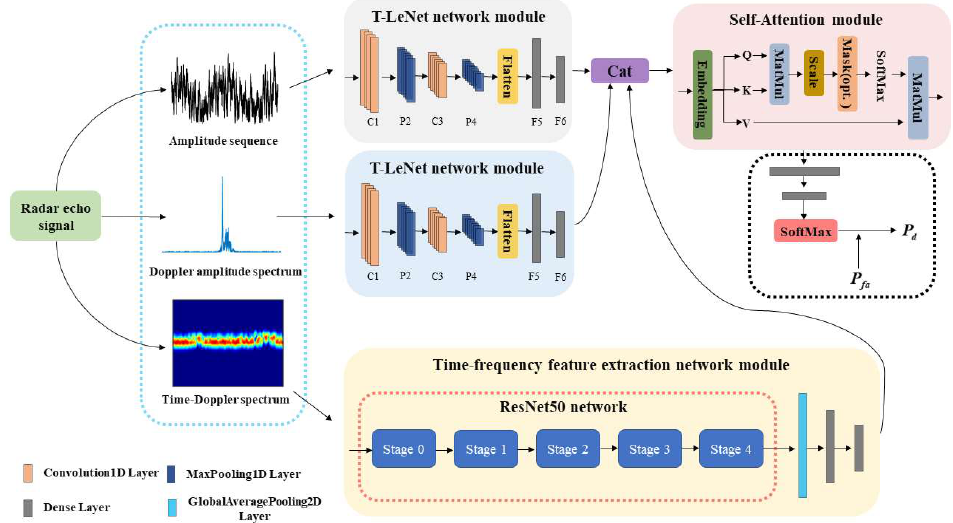
Figure 3. The flowchart of the proposed target detection network model.